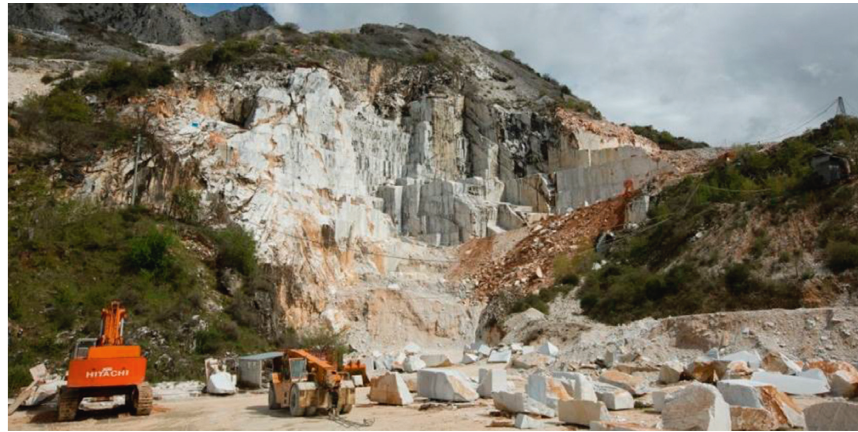
Figure 1: Quarry around the